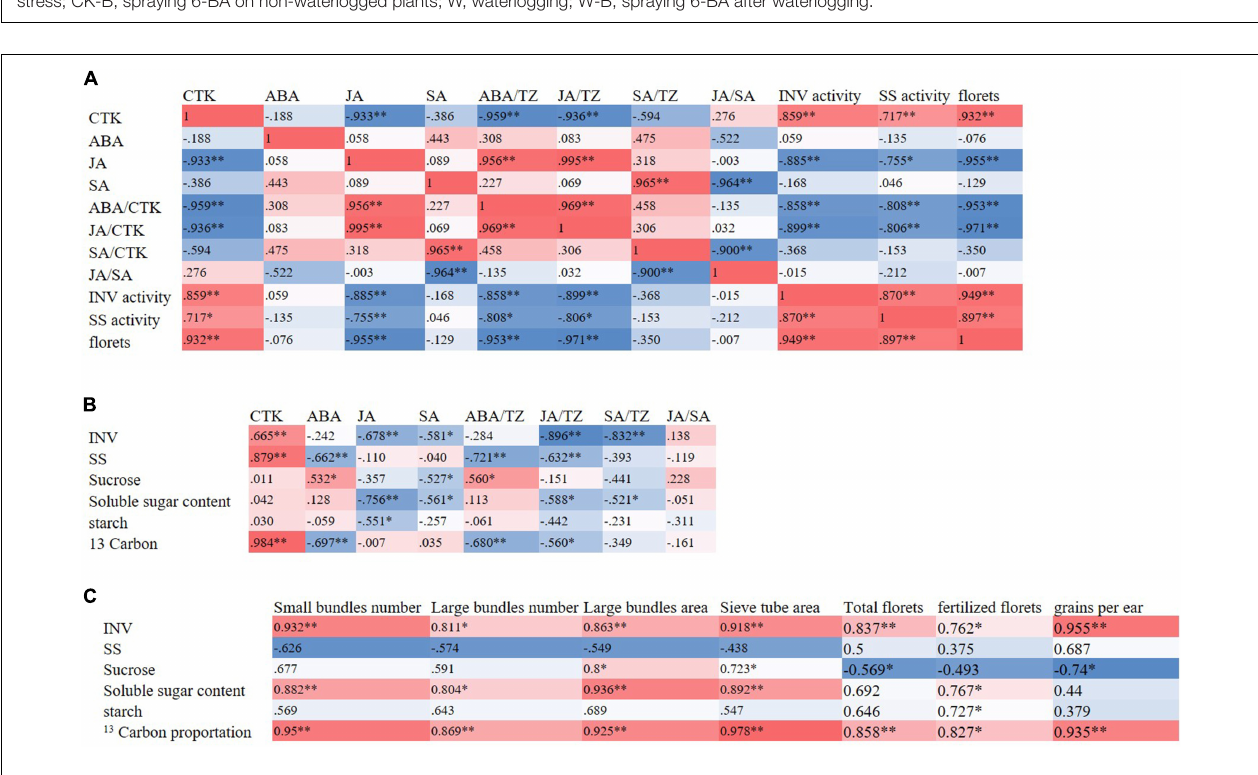
FIGURE 8 | Correlation heat maps. According to the correlation coefficient value of hormones contents, sucrose-cleaving enzymes, sucrose contents, 13 C distributions, and yields and yield components, the thermal map (heat map) was drawn. Red (1) represents a significant positive correlation and blue (-1) represents a significant negative correlation. The darker the color of the color block, the stronger the correlation. (A) Correlation heat map of hormone contents with sucrose cleaving enzymes and ear traits in ears at the T1 stage, (B) correlation heat map of hormone contents with sugar metabolism and 13 C distribution characteristics in spike nodes and ears at the T2 stage, (C) correlation heat map of sugar metabolism and 13 C distribution characteristics with spike node structure and ear characteristics at T2 stage. INV, sucrose invertase; SS, sucrose synthase enzyme; T1, florets differentiation stage; T2, sexual organ formation stage; * and ** respectively indicate the significant differences among treatments at P < 0.05 and P < 0.01 using the LSD test.